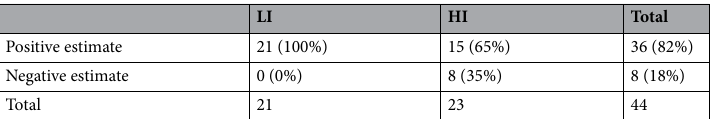
Table 2. Contingency table between impulsiveness groups and the adaptation of the PBI across blocks as indexed by the model estimates. A positive estimate indicates a global increase in the PBI across blocks, used as an index of adaptation capacities. A negative estimate indicates an absence of evolution or even a decrease in the PBI across blocks and thus, no adaptation to task demands. LI : low impulsiveness, HI : high impulsiveness.